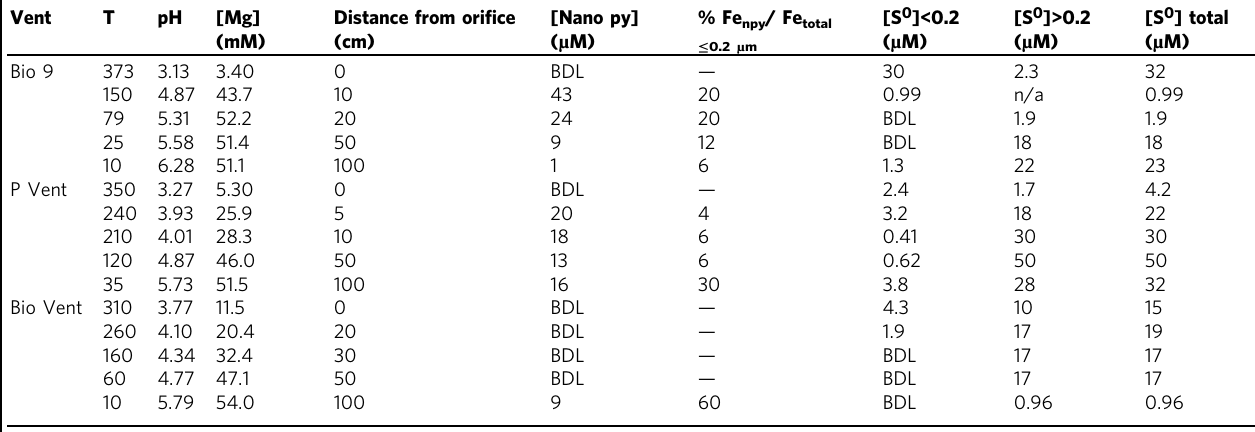
Table 1 Nanoparticulate pyrite and elemental sulfur concentrations in each sample